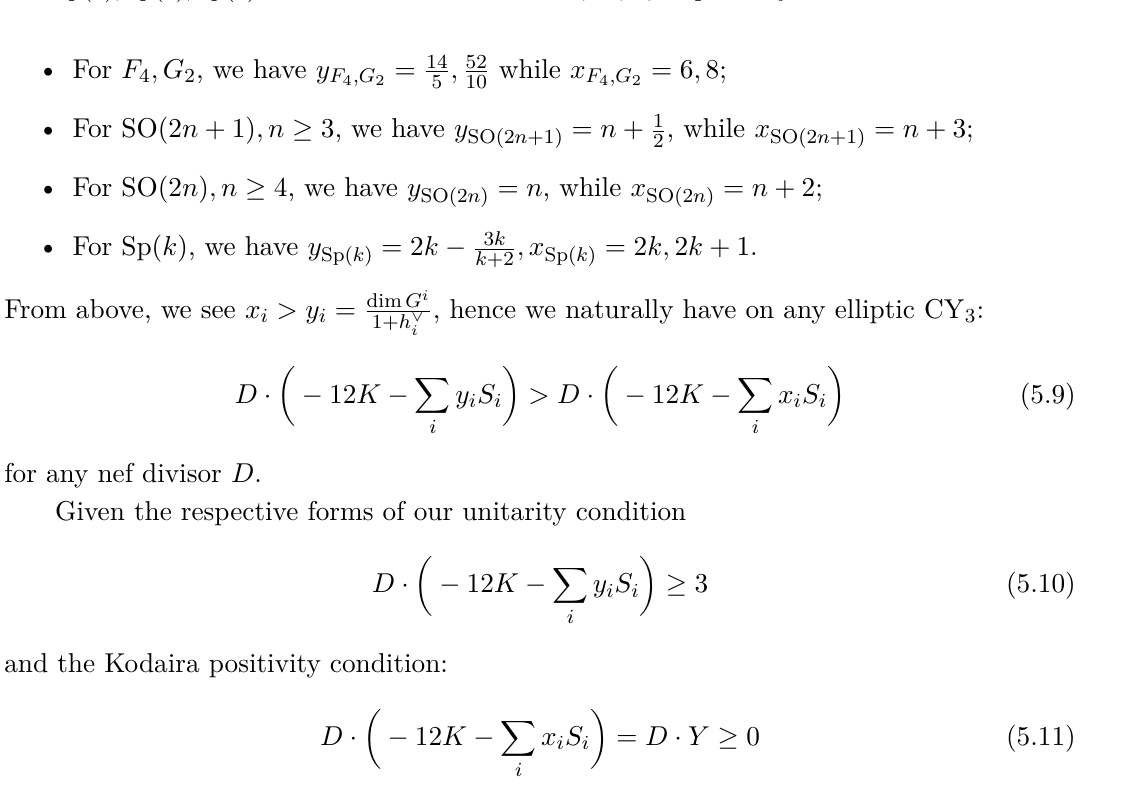
Table 2 . Classification of gauge groups in table 1 based on the minimal value of x i − y i . Notice that sp (1) , sp (2) , sp (3) in the first row come from I 2 , I 4 , I 6